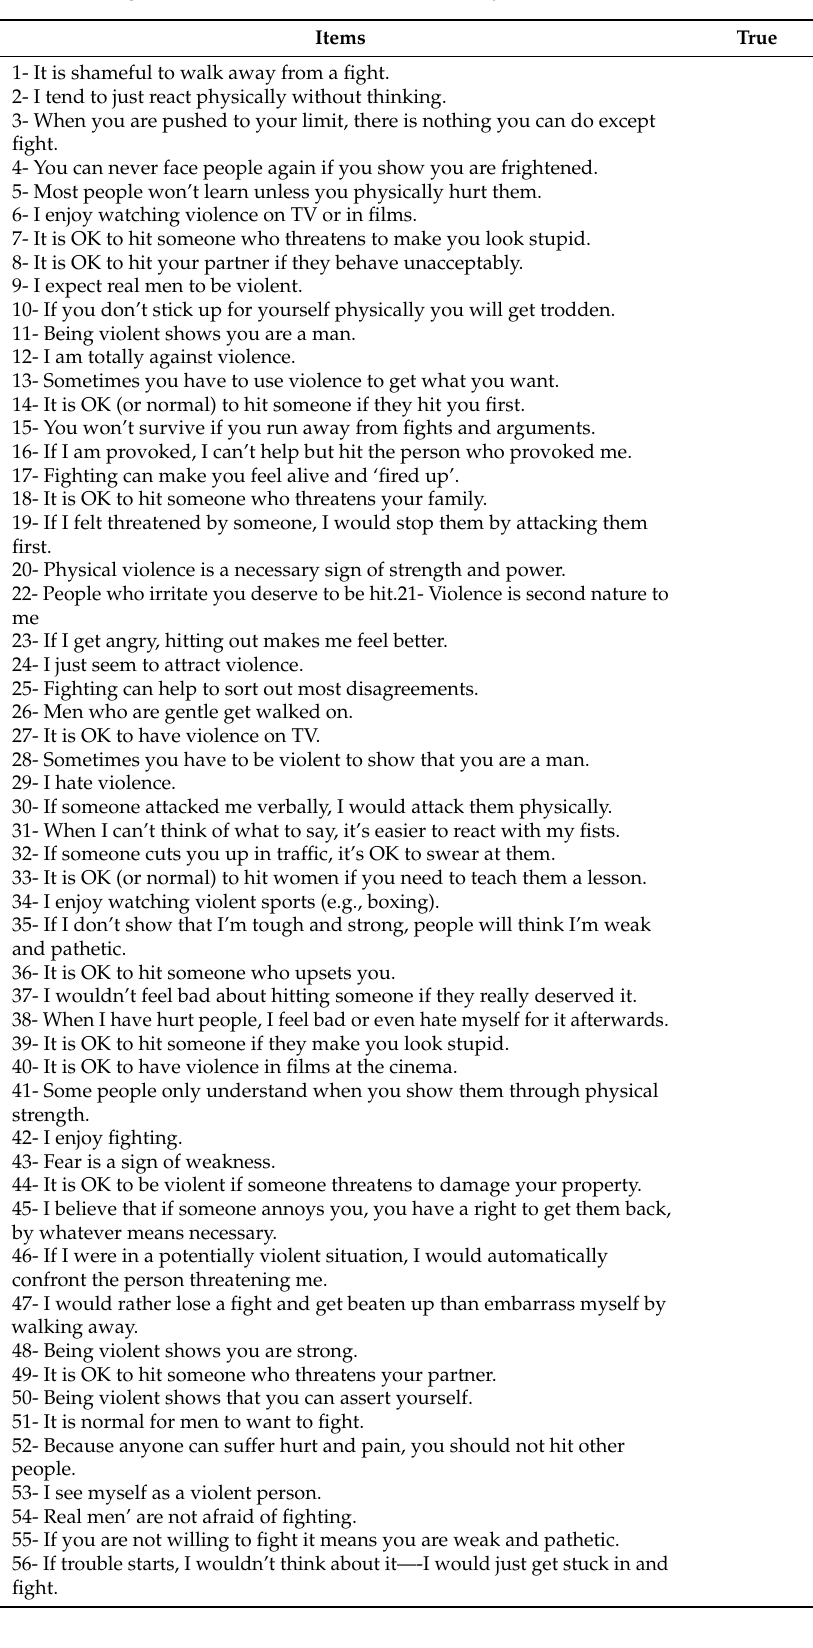
Table A2. English version of the items of Maudsley Violence Questionnaire